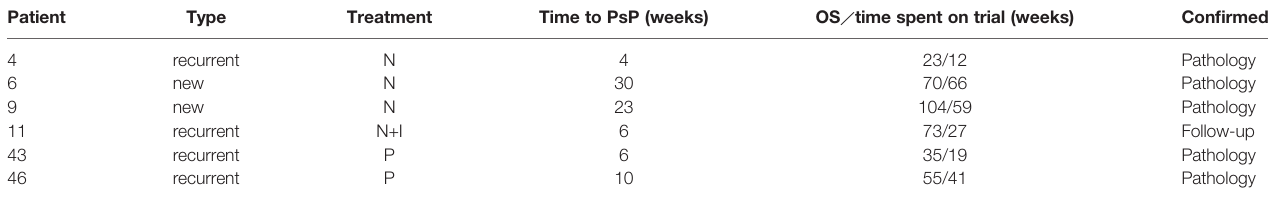
TABLE 4 | Pseudoprogression characteristics in 6/49 glioblastoma